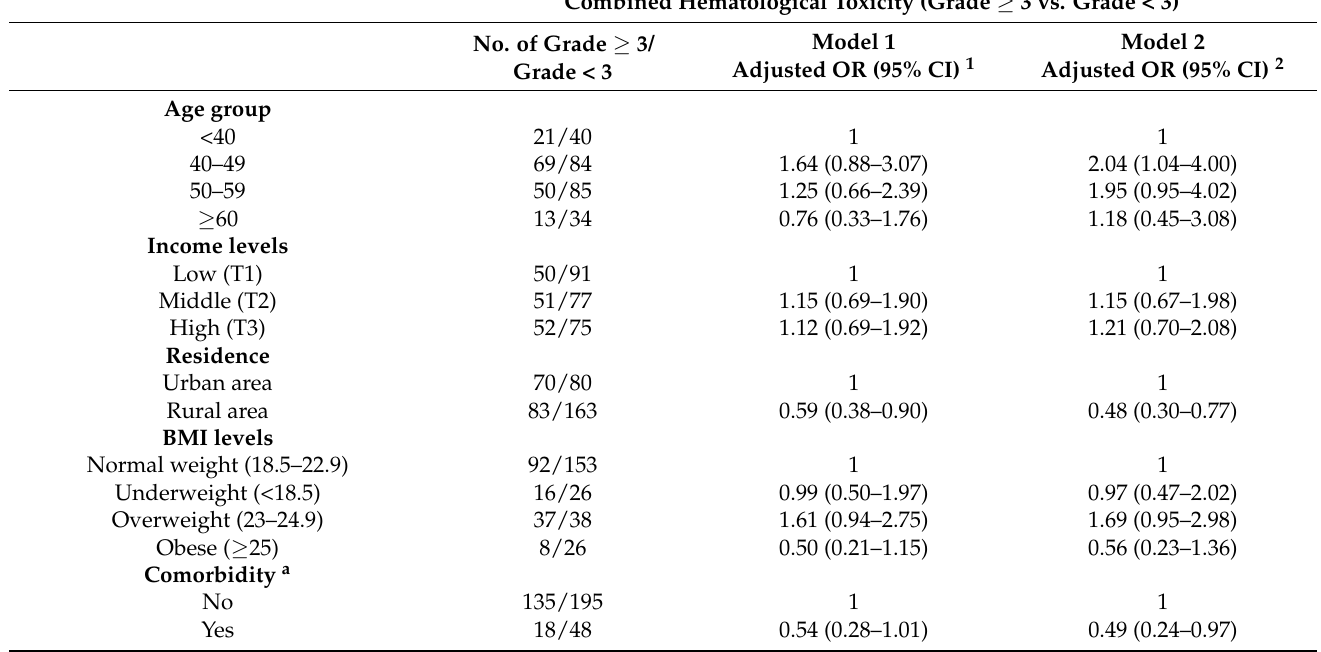
Table 3. Association of demographic characteristics and clinical factors with combined hematological